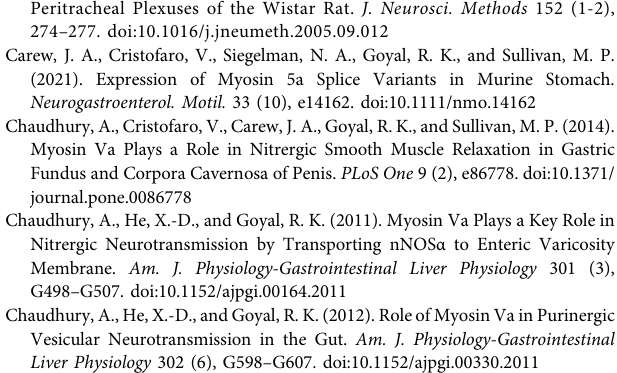
band intensity ± SE is graphed for all replicates of each genotype in panel (F) . Black circles represent WT mucosa, gray squares, DBA mucosa. There was more